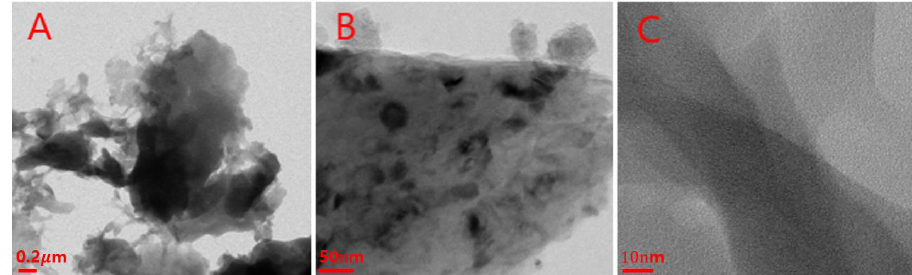
Figure 2 . TEM image of cellulose nanocrystal (( A ): 0.2 μm, ( B ): 50 nm, ( C ): 10 nm). Figure 2. TEM image of cellulose nanocrystal (( A ): 0.2 µ m, ( B ): 50 nm, ( C ): 10